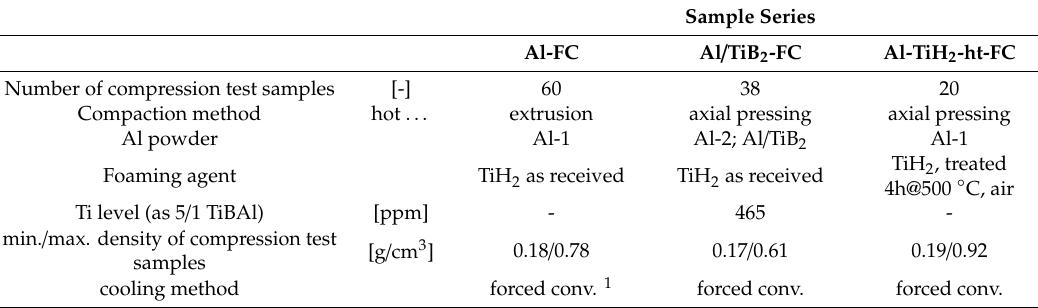
Table 3. Overview of foam sample series for mechanical testing. As also implied by the series’ designations, forced convection cooling was employed in all